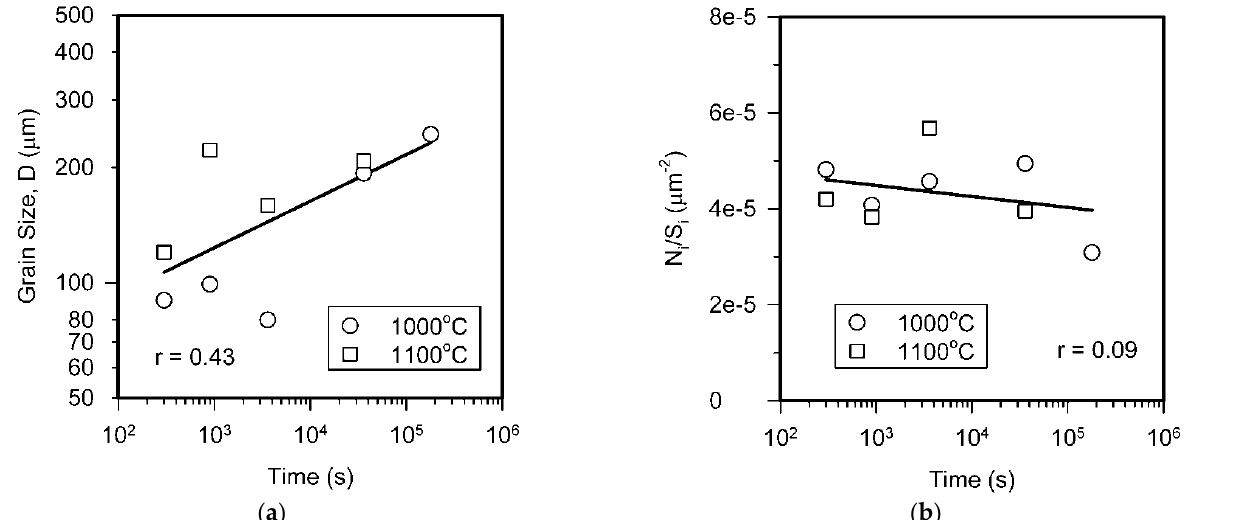
Figure 5. Effect of annealing time on the grain size ( a ) and the number of grain boundary interruptions per unite area ( b ) for a 316L stainless steel subjected to recrystallization annealing followed by grain growth. The values of the determination coefficient (r) correspond to the linear regressions.